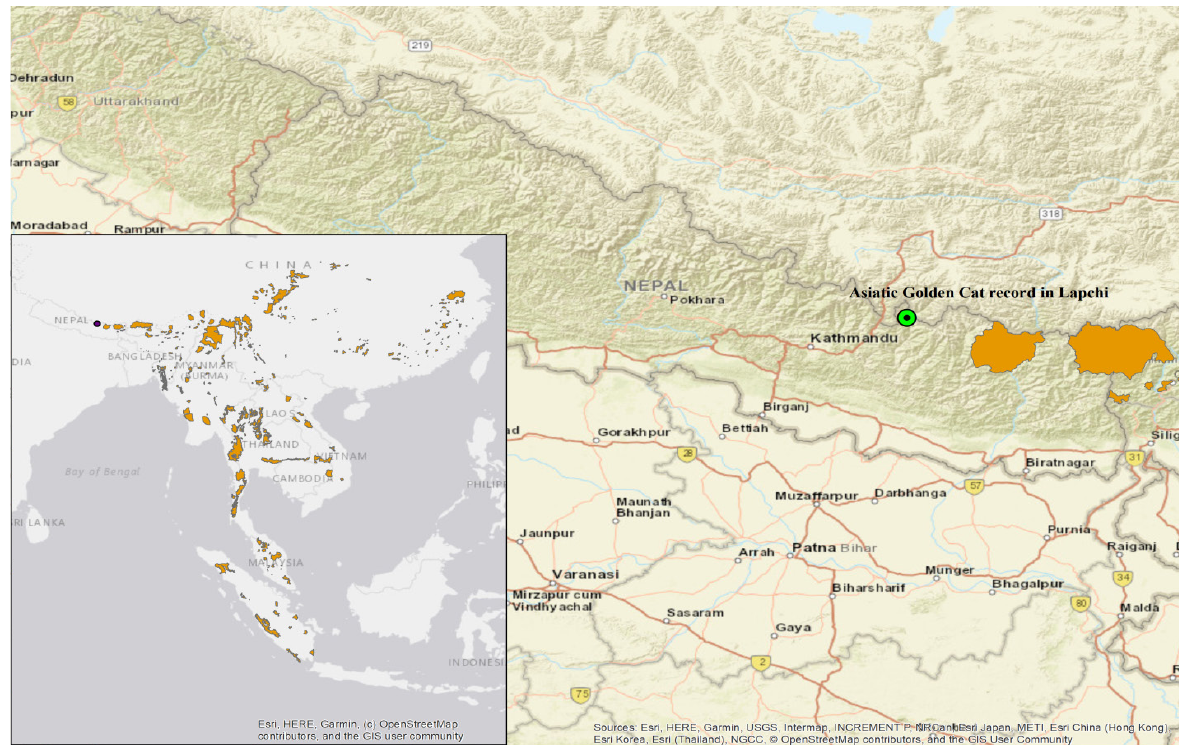
Figure 1. Asiatic Golden Cat recorded in Lapchi Valley of Gaurishankar Conservation Area (green circle with black dot) and the current global distribution of Asiatic Golden Cat (in orange, map modified from McCarthy et al.